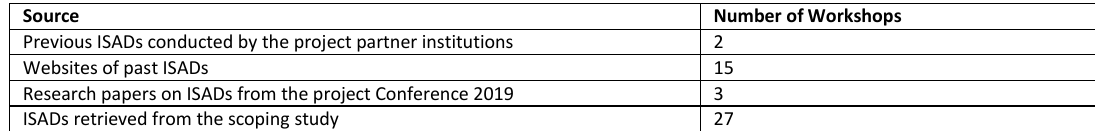
Table 5 Number of workshops based on data source